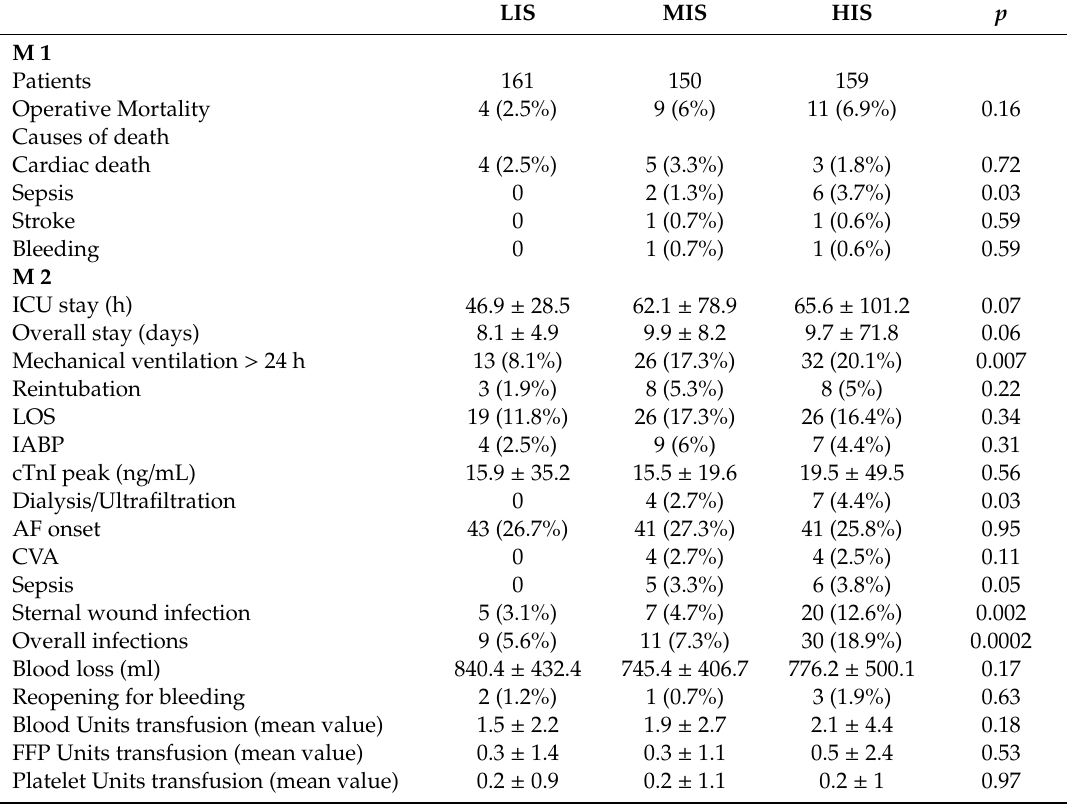
Table 3. Post-operative mortality (M 1) and morbidity (M 2), related to pre-operative inflammatory status. LIS MIS HIS p M 1 Patients 161 150 159 Operative Mortality 4 (2.5%) 0.16 Causes of death Cardiac